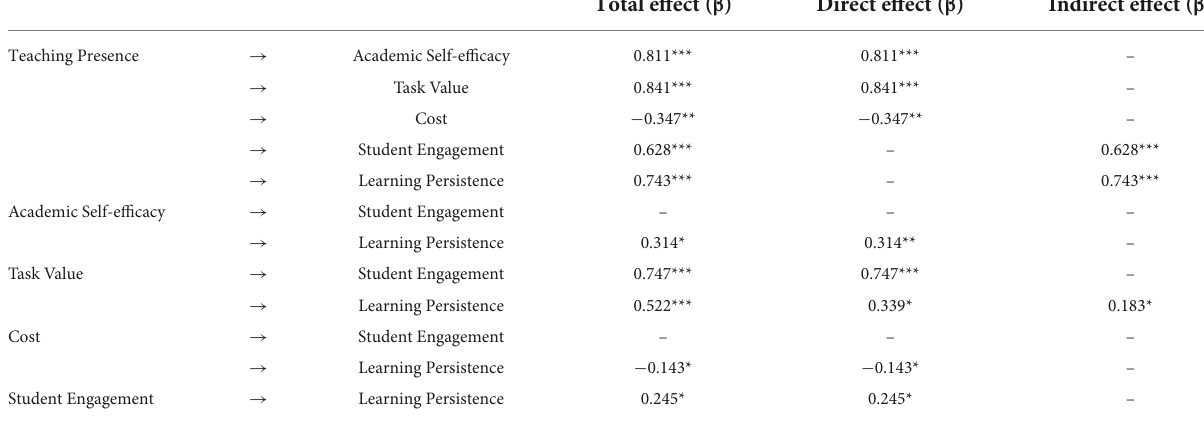
TABLE 2 Total, direct, and indirect effects among variables.